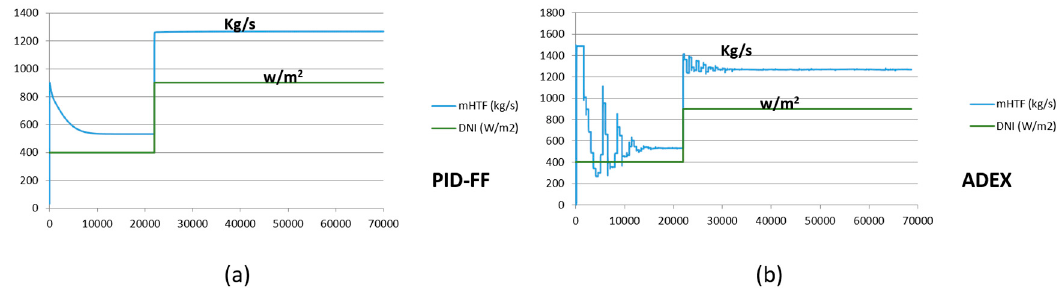
Figure 8. Mass flow response to a sharp DNI, for the PID-FF ( a ) and ADEX ( b ) controllers.